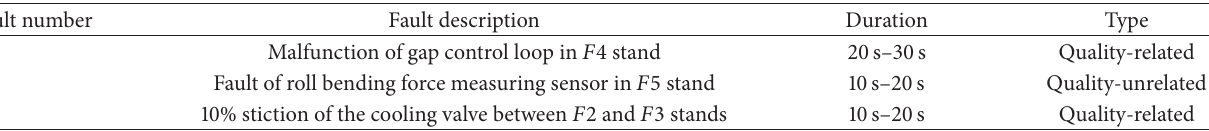
Table 1: Faults that occurred in FMP.